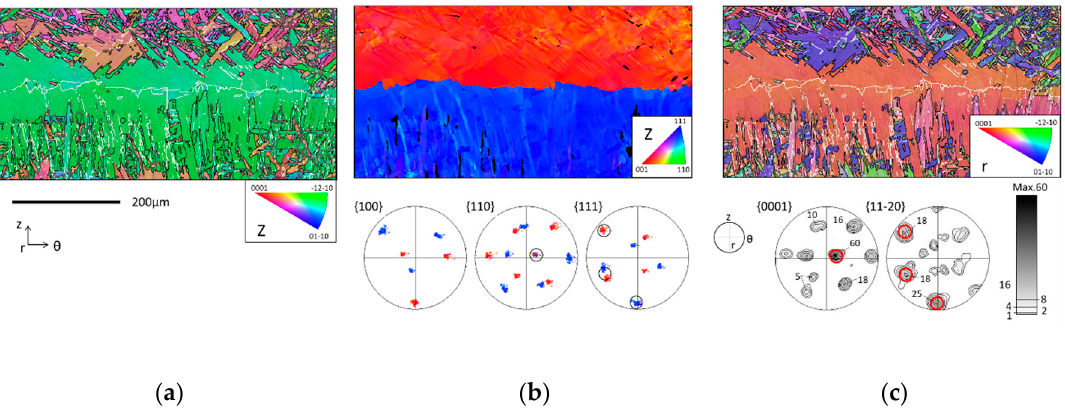
Figure 6. EBSD map acquired below the facet: ( a ) measured α IPF//z map (angular misorientations between 3–15°: in white); ( b ) reconstructed β -IPF//z map and discrete PFs of β orientations close to the boundary; ( c ) measured α -IPF//r map (angular misorientations between 3–15°: in white) and corresponding α PF densities. The β / α poles implicated in the GB variant selection according to BOR are encircled on the corresponding PFs.